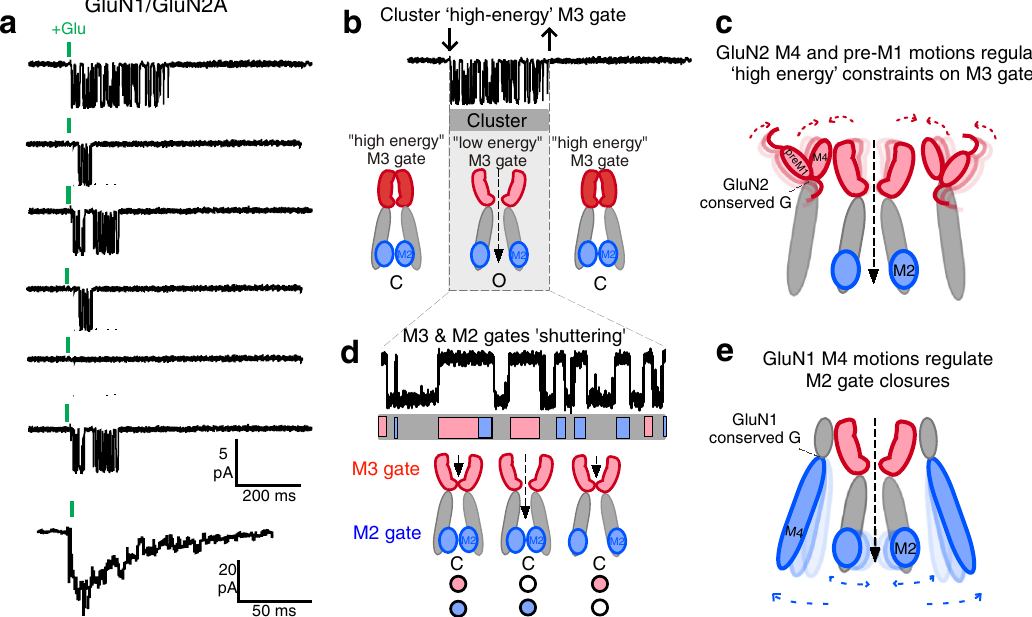
Fig. 6 | Two gates that are modulated by speci fi c subunits mediate NMDAR synapticactivity.a ResponseofNMDARstobriefsynapticlikepulsesofglutamate. NMDARs enter a ‘ cluster ’ of activity. Summed current is shown at the bottom. b Entry into and exit from a cluster are driven by a ‘ high-energy ’ M3 gate, which presumablyopens fi rstforionchannelactivity.Structuralfeaturesdrivingthehigh- energy M3 gate include the tension across the M3-S2 linker as well as the posi- tioningoftheouterstructures – thepre-M1andM4helices. c GluN2M4andpre-M1 regulate entry into and exit from clusters. The status of the M2 loop gate, whether